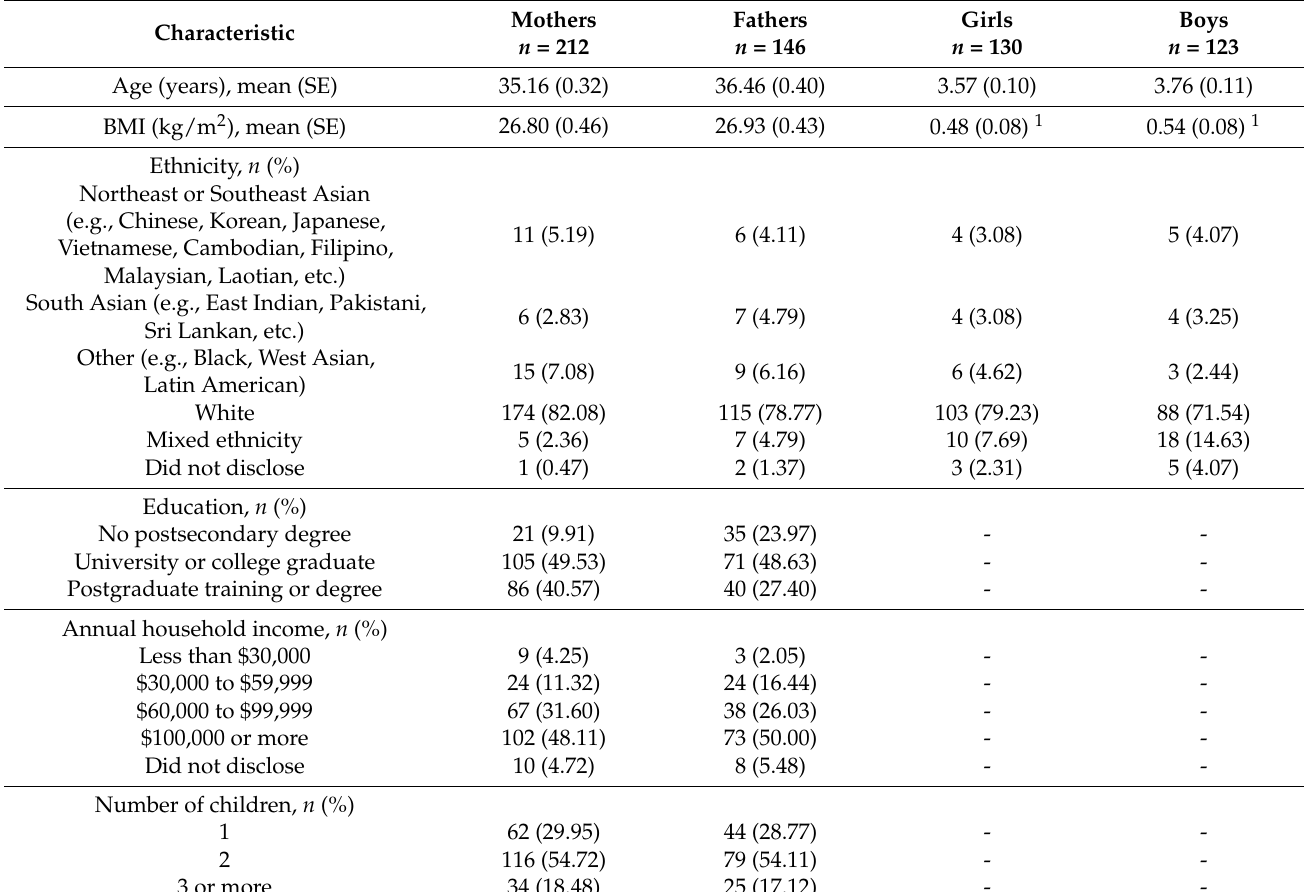
Table 1. Family demographic characteristics ( n = 611 participants from 241